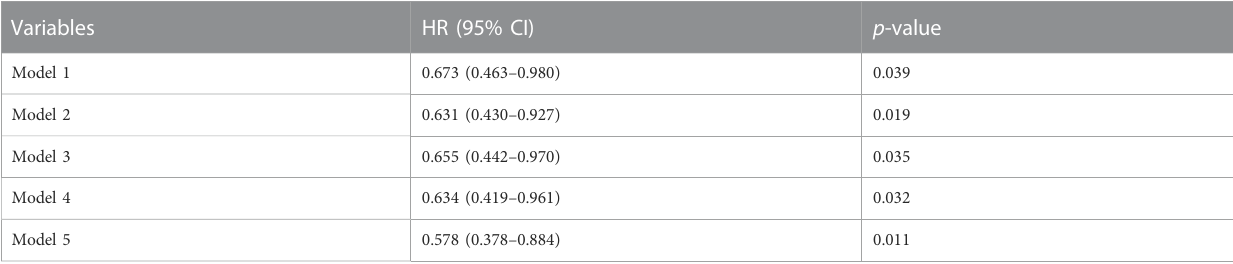
TABLE 3 Cox regression model showing HRs for 28-day mortality was related to human albumin administration. Variables